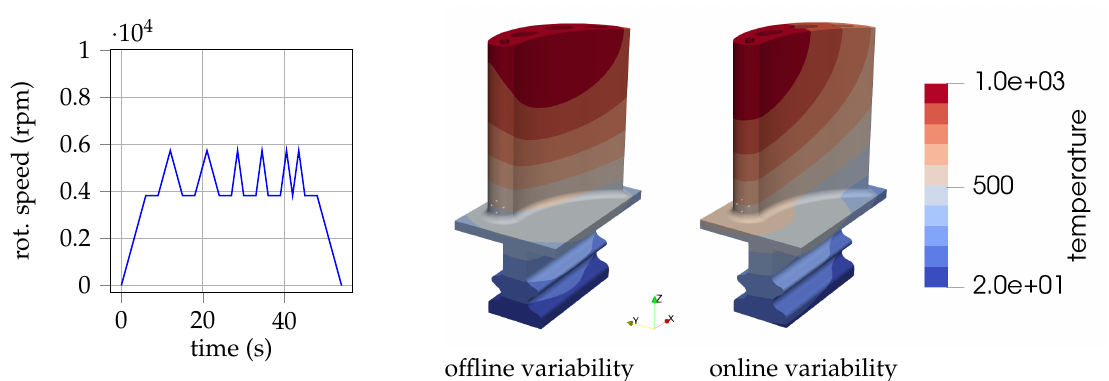
Figure 11. High-pressure turbine test case: ( left ) rotation speed with respect to time; ( right ) representation of maximum temperature fields used in the offline and online computations; the axis of rotation is located below the blade along the x -axis.